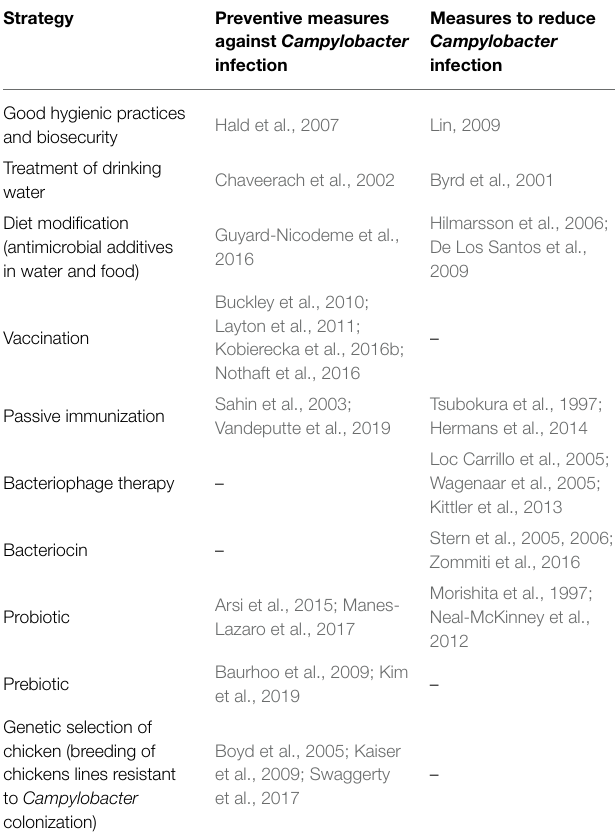
TABLE 1 | Proposed strategies to control the Campylobacter infection for use on